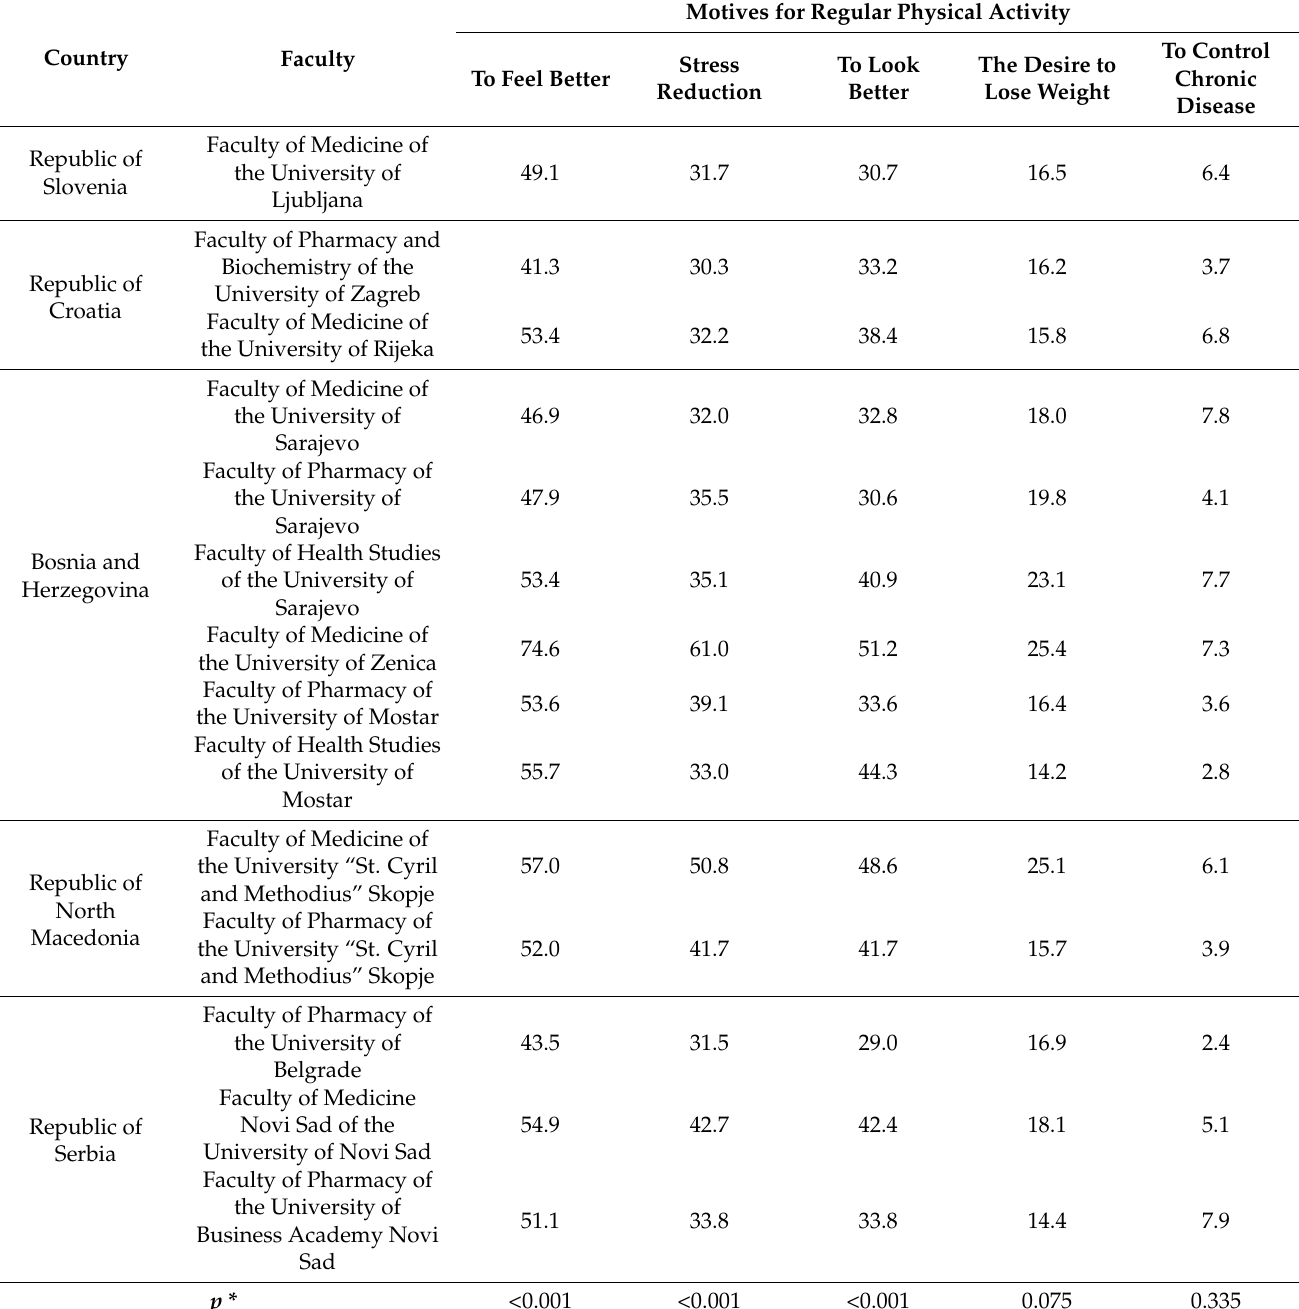
Table 4. Motives for regular physical activity among medical students, in relation to the attended faculty